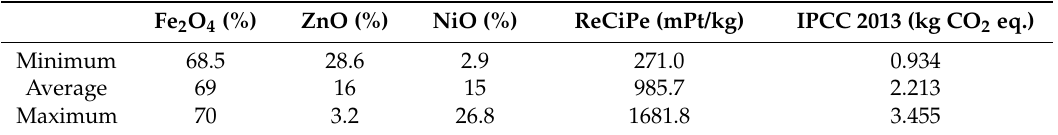
Figure 5. NiZn soft ferrite environmental impact diagram.